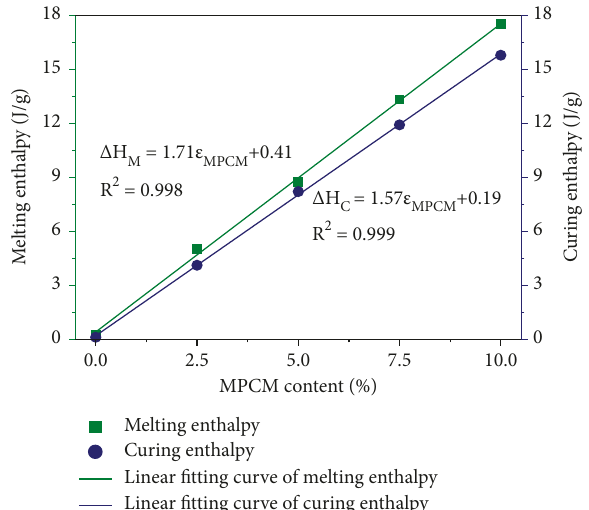
Figure 10: Effect of the MPCM content on melting and curing